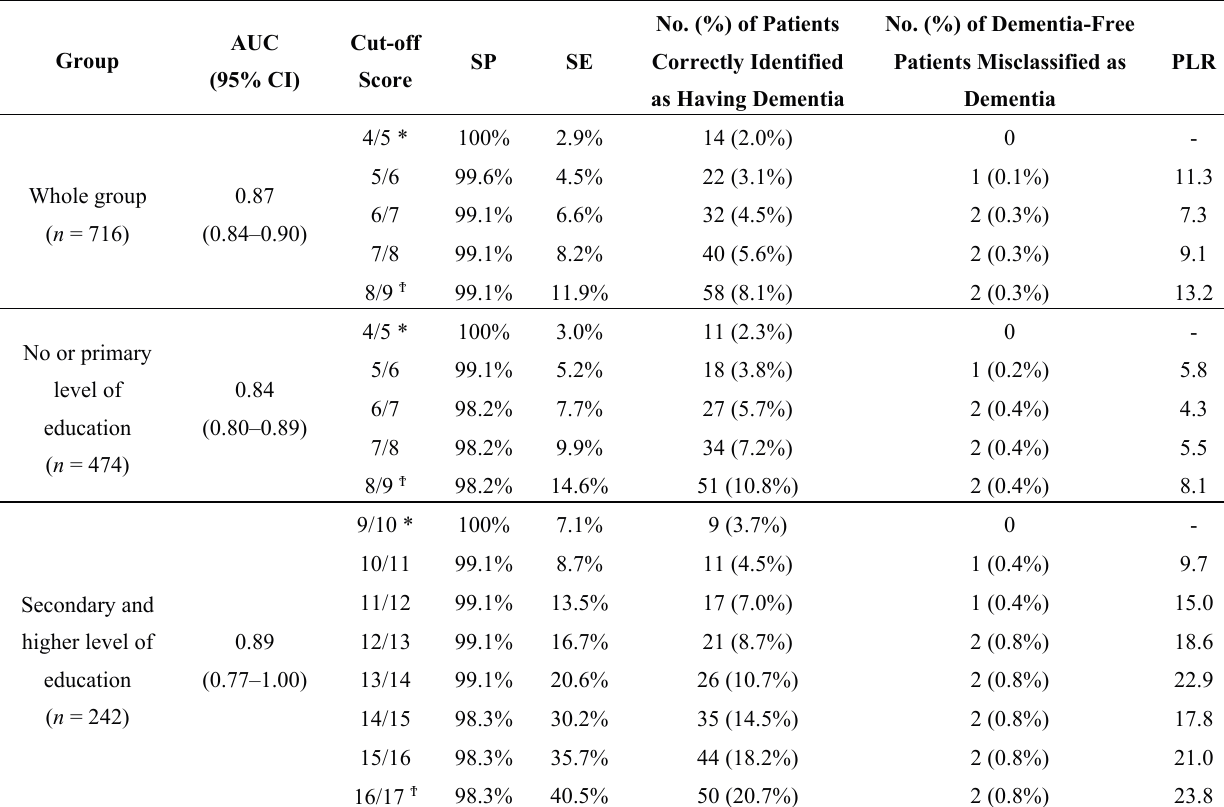
Table 2. Area Under Curves (AUCs), MMSE cut-off scores, Specificity (SP), Sensitivity (SE), number (%) of patients correctly identified, number (%) of patients misclassified as dementia, and PLRs before and after education